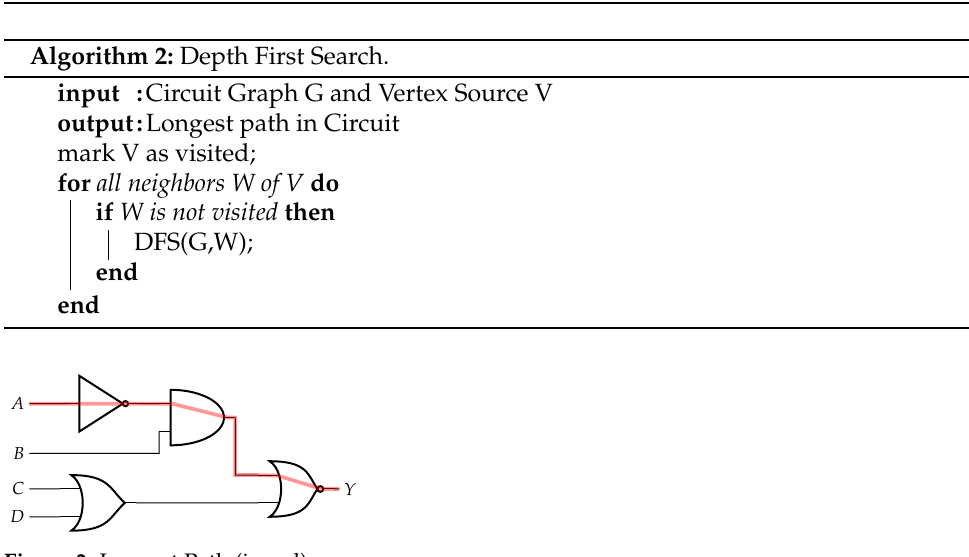
Figure 3. Longest Path (in